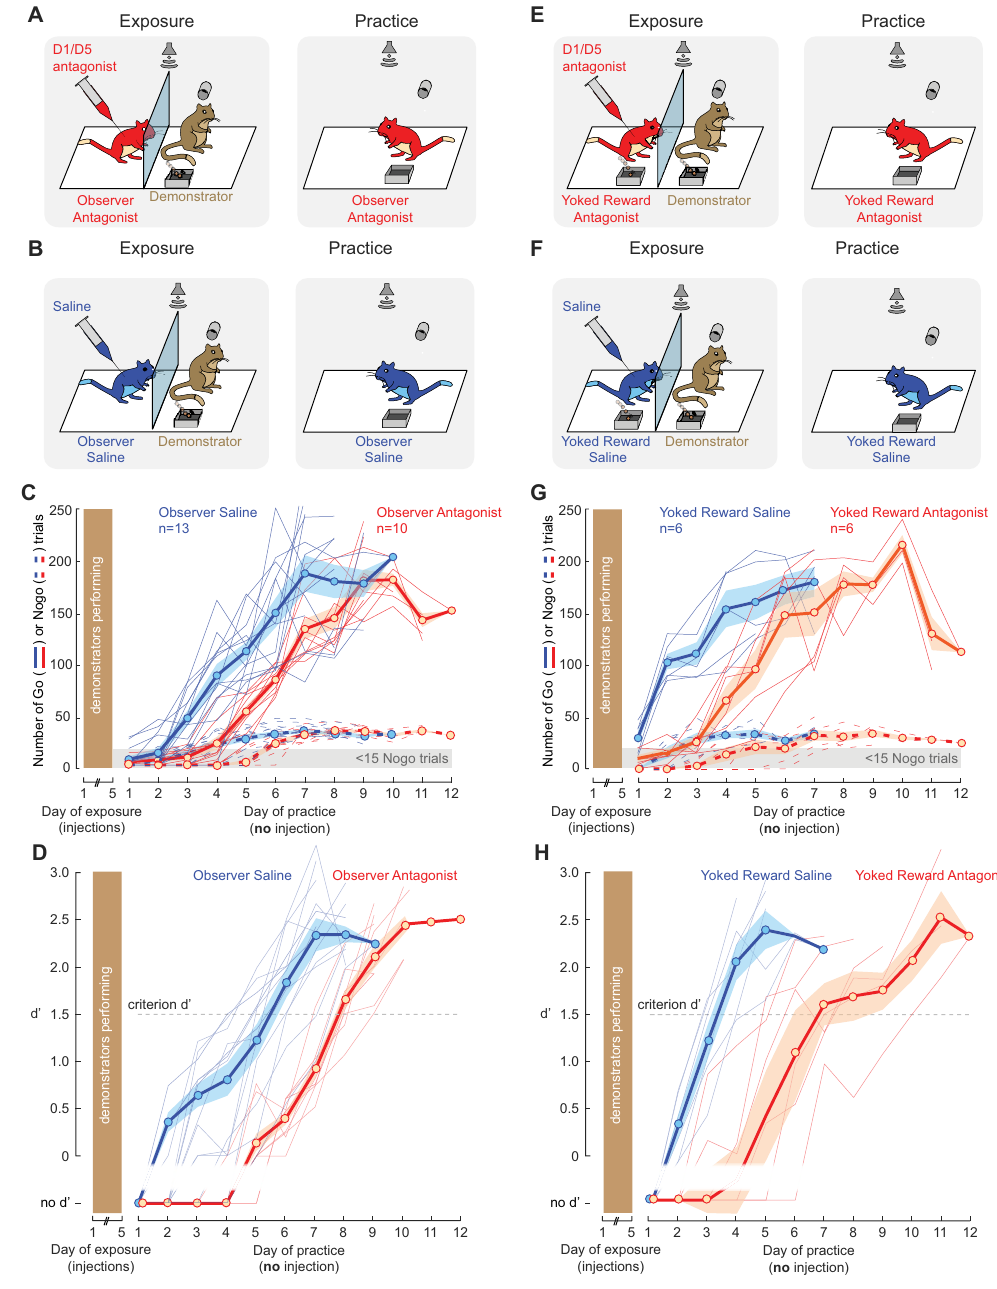
Figure 2. Decrease of tonic dopamine level degrades social learning. ( A ) Prior to each exposure session, the naïve observer gerbils were given an injection of a dopamine receptor antagonist (5 males; age = 99.5 ± 8.6 days; see “Methods” section for details). After 15–20 min of recovery, the exposure session began (left) with same- sex demonstrators (age = 138 ± 3.7). No drug was injected during the practice sessions (right). ( B ) Similar to A , except that saline was injected to the observers (5 males; age = 104.3 ± 10.7) prior to each exposure session (left) with the demonstrators (age = 143 ± 5.4). No drug was injected during the practice sessions (right). ( C ) Individual and mean ± SEM of the overall number of Go and Nogo trials performed by the observer gerbils during the practice sessions (antagonist-injected observers in red and saline-injected observers in blue). ( D ) Individual and mean ± SEM of the performance d ′ of the observer gerbils as a function of practice sessions. ( E ) Prior to each exposure session, the yoked reward observer gerbils were given an injection of a dopamine receptor antagonist (4 males; age = 111.3 ± 8.9). After 15–20 min of recovery, the exposure session began (left) with the demonstrators (age = 166 ± 4.5). No drug was injected during the practice sessions (right). ( F ) Similar to E , except that saline was injected to the observers (5 males; age = 110.3 ± 8.5) prior to each exposure session (left) with the demonstrators (age = 119 ± 5.7). No drug was injected during the practice sessions (right). ( G ) Similar to C for the yoked reward observers. ( H ) Similar to D for the yoked reward